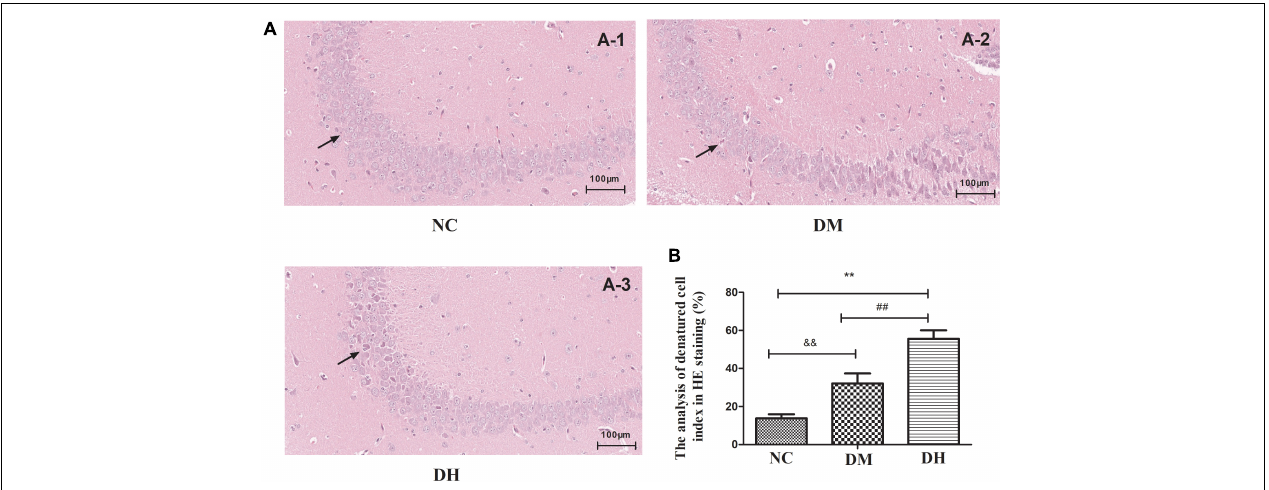
FIGURE 3 | Severe hypoglycemia under diabetic conditions causes histological changes in the hippocampal region. The black arrowheads indicate layers of pyramidal cells. (A-1) : NC; (A-2) : DM; (A-3) : DH. Scale bar = 100 µ m (HE staining). N = 3 per group. Data are the means ± SEM. ** P < 0.01 NC vs. DH, && P < 0.01 NC vs. DM, ## P < 0.01 DM